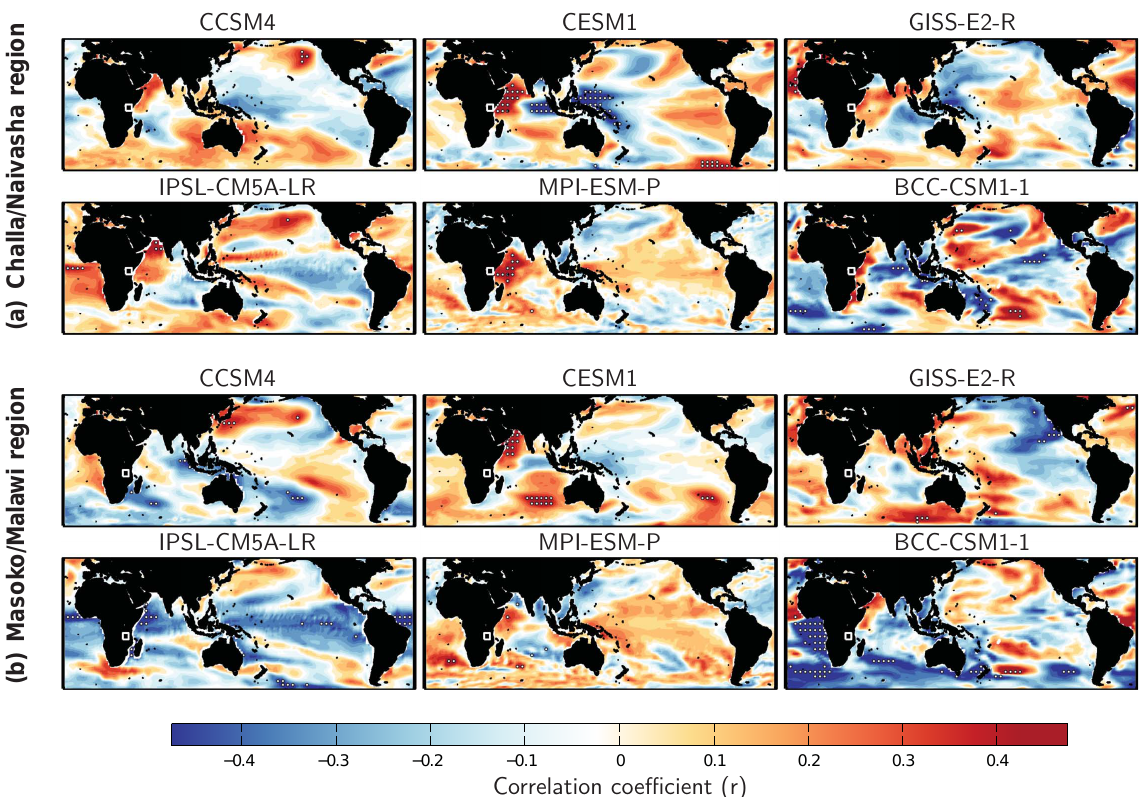
Figure 11. Pearson correlation coefficients between global SSTs and mean annual rainfall over the Challa–Naivasha (a) and Masoko– Malawi (b) regions, using the pre-industrial control runs of the climate models. Rainfall and SSTs are mean annual values smoothed using a loess filter with a window of 100 years. In areas overprinted by white circles the null hypothesis of no correlation can be rejected at the 5%